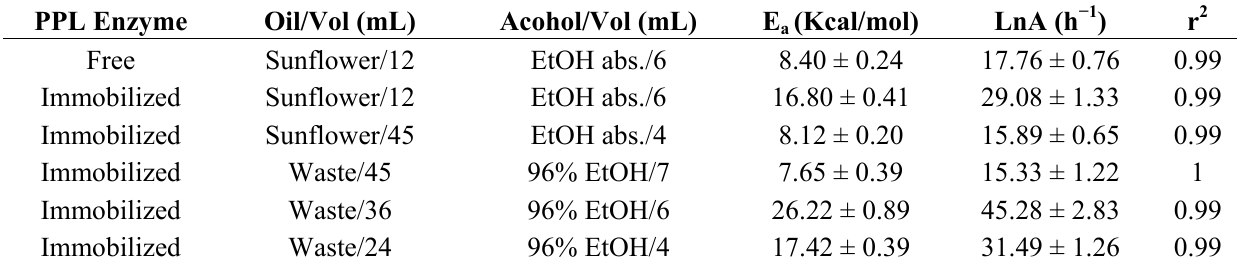
Table 4. Activation Energy values E (Kcal/mol) and preexponential factor LnA (h − 1 ), a obtained in the ethanolisis reaction of oils with free and immobilized at pH =